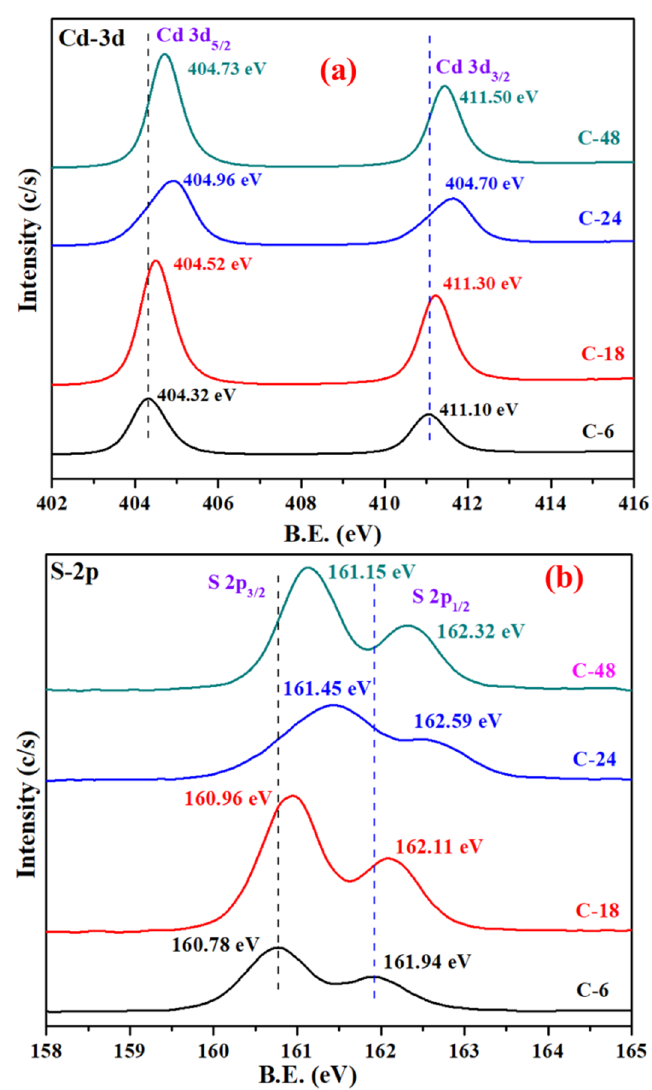
Figure 5. High resolution XPS spectra of ( a ) Cd-3d and ( b ) S-2p of CdS nanorods prepared at different reaction times.